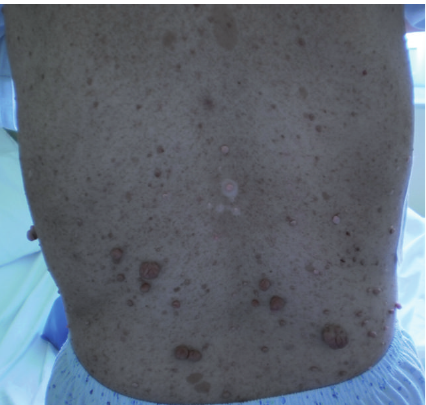
Figure 1: Multiple caf´e-au-lait spots and cutaneous neurofibromas of variable size were noted throughout the patient’s body.